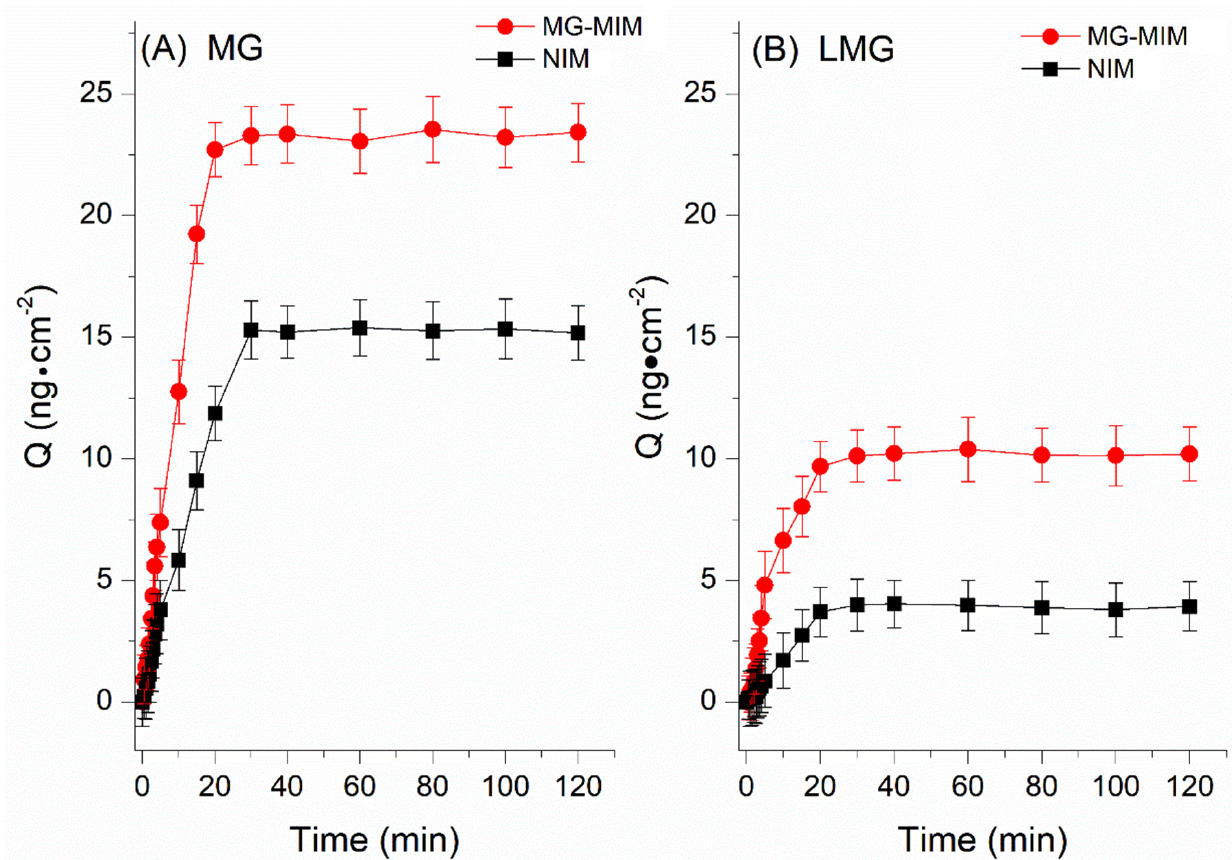
Figure 7. Adsorption dynamic curves of ( A ) MG and ( B ) LMG.